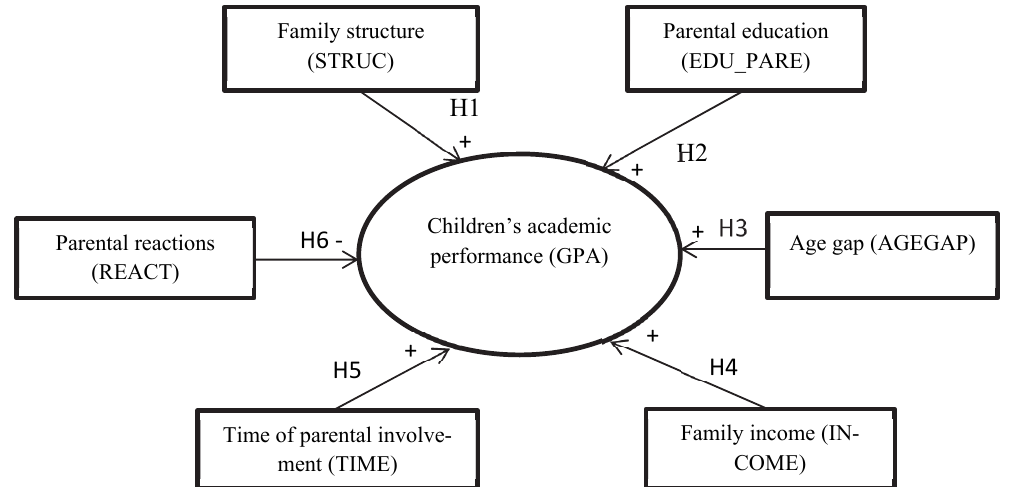
Fig. 1. The family determinants of academic